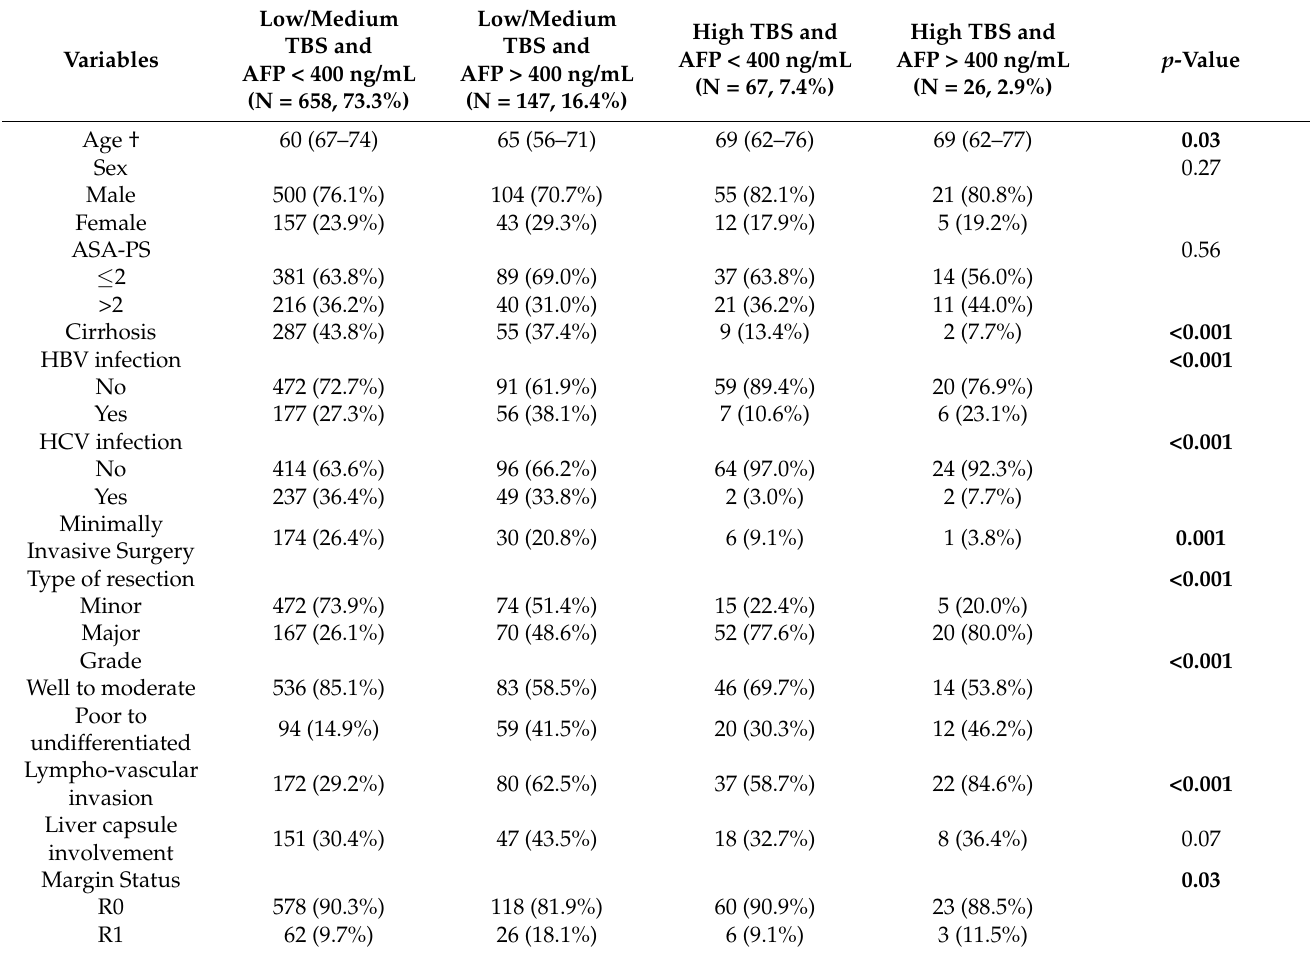
Table 2. Characteristics of patients stratified by TBS and AFP